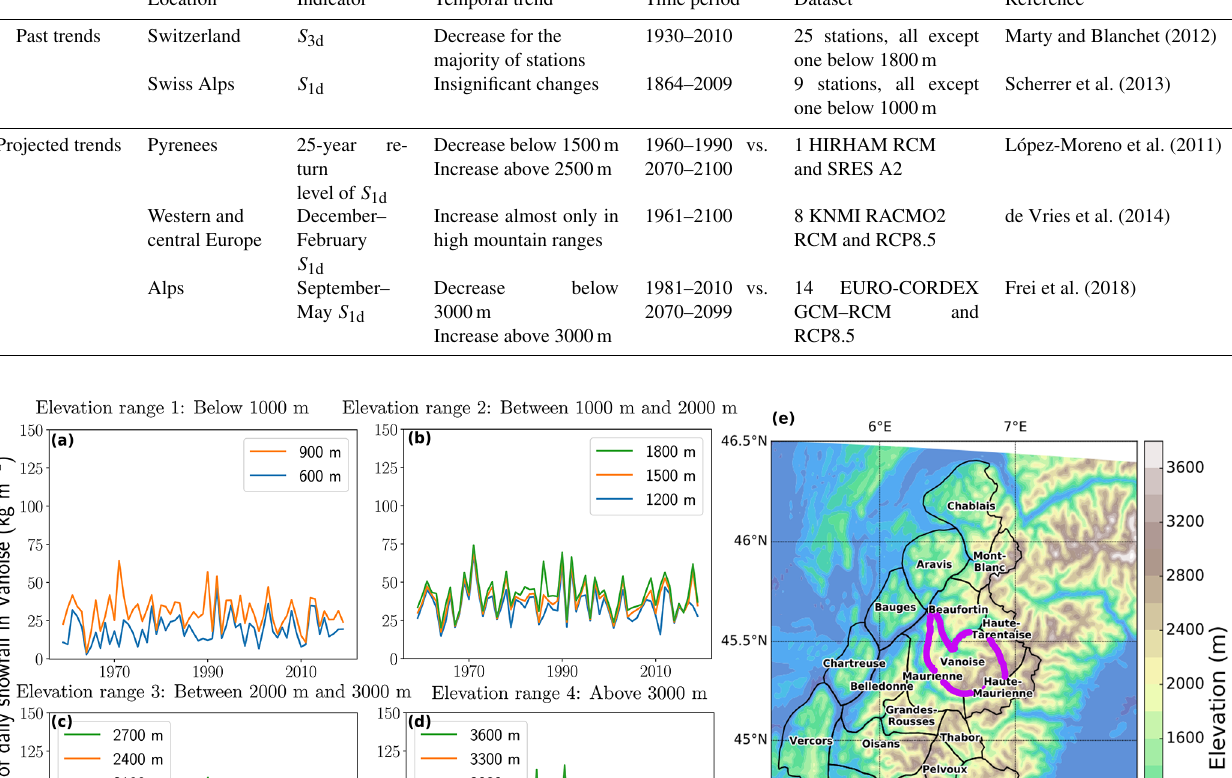
indirectly with various snow depth observations